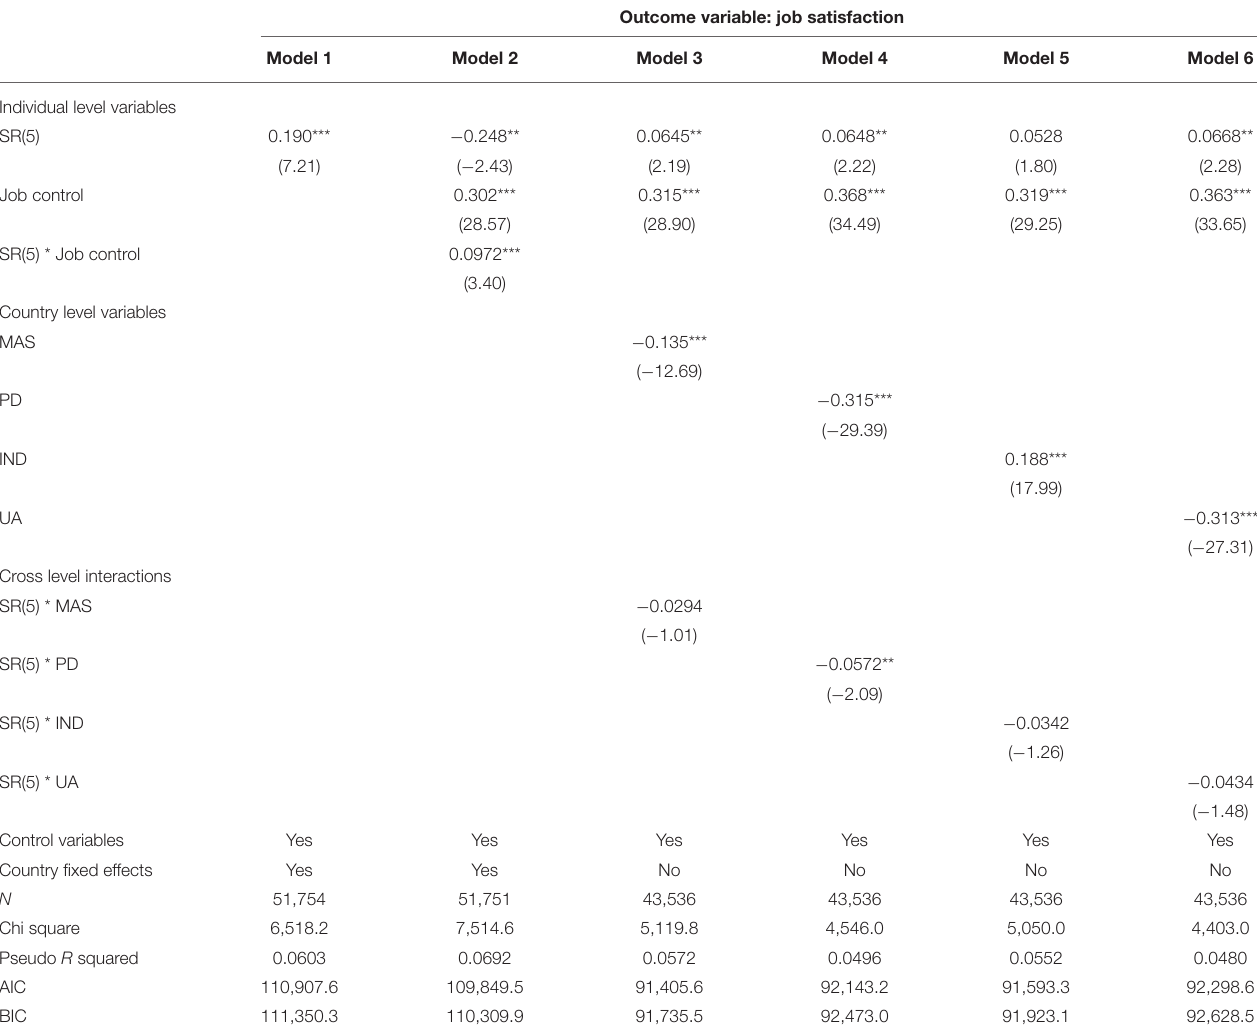
TABLE 3 | Ordered logit estimations for job satisfaction with supervisory responsibility for at least five